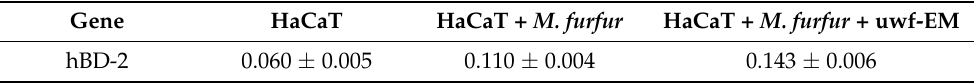
Table 4. Numeric representation of the antimicrobial peptide compared to the control as averages of three replicates along with the corresponding standard